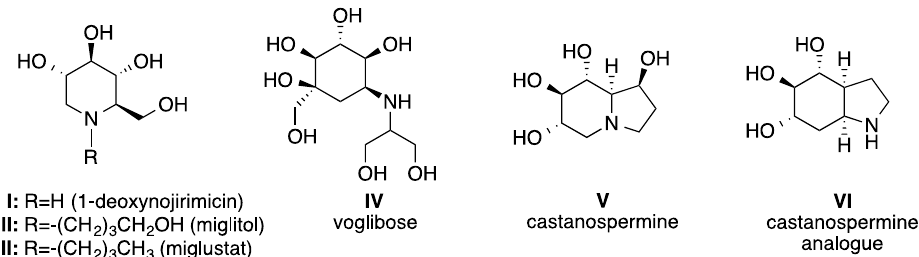
Figure 1. Selection of iminosugars and aminocarbasugars.